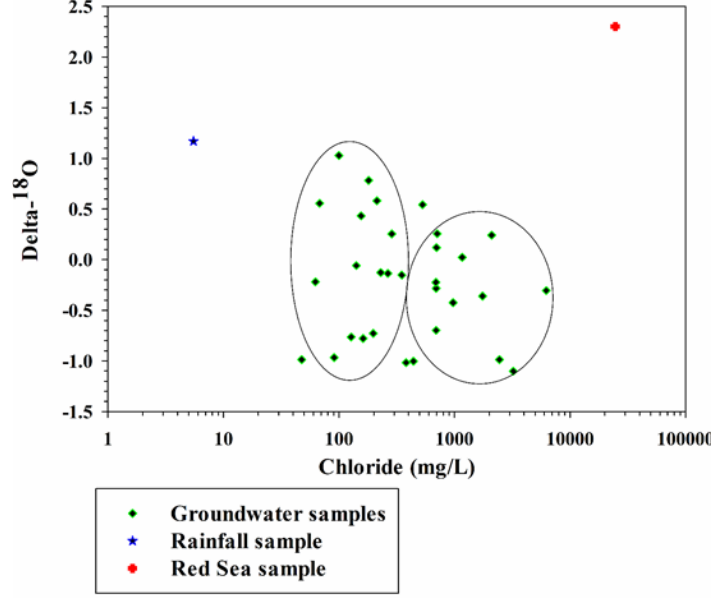
Figure 5. Relationship between Cl and δ 18 O values of water samples.